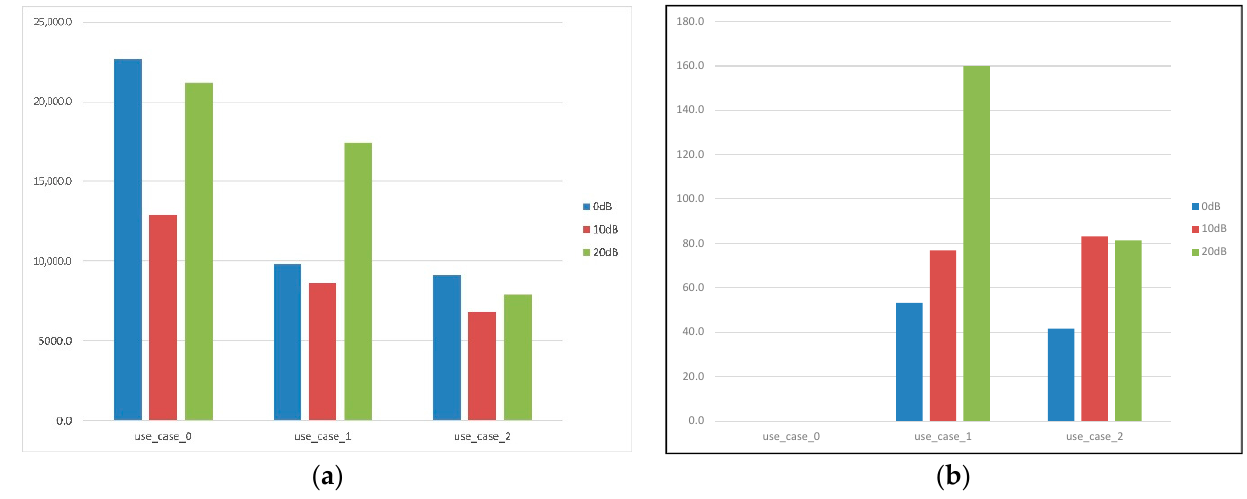
Figure 11. Route Request (RREQ) messages received by one node ( a ) and RREQ messages overwritten by one node ( b ).